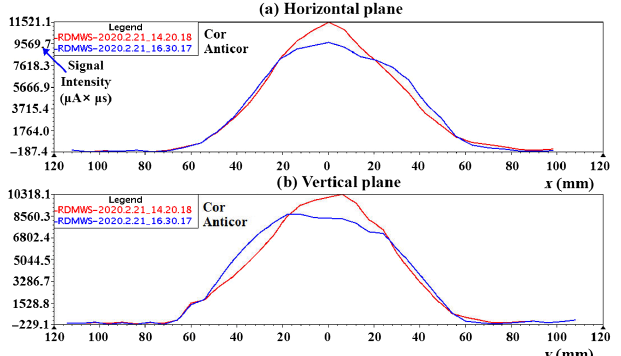
FIG. 11. Comparison of the transverse beam distributions for the correlated and anticorrelated painting in the beam commis- sioning. Subgraph (a): horizontal beam distributions; subgraph (b): vertical beam distributions.